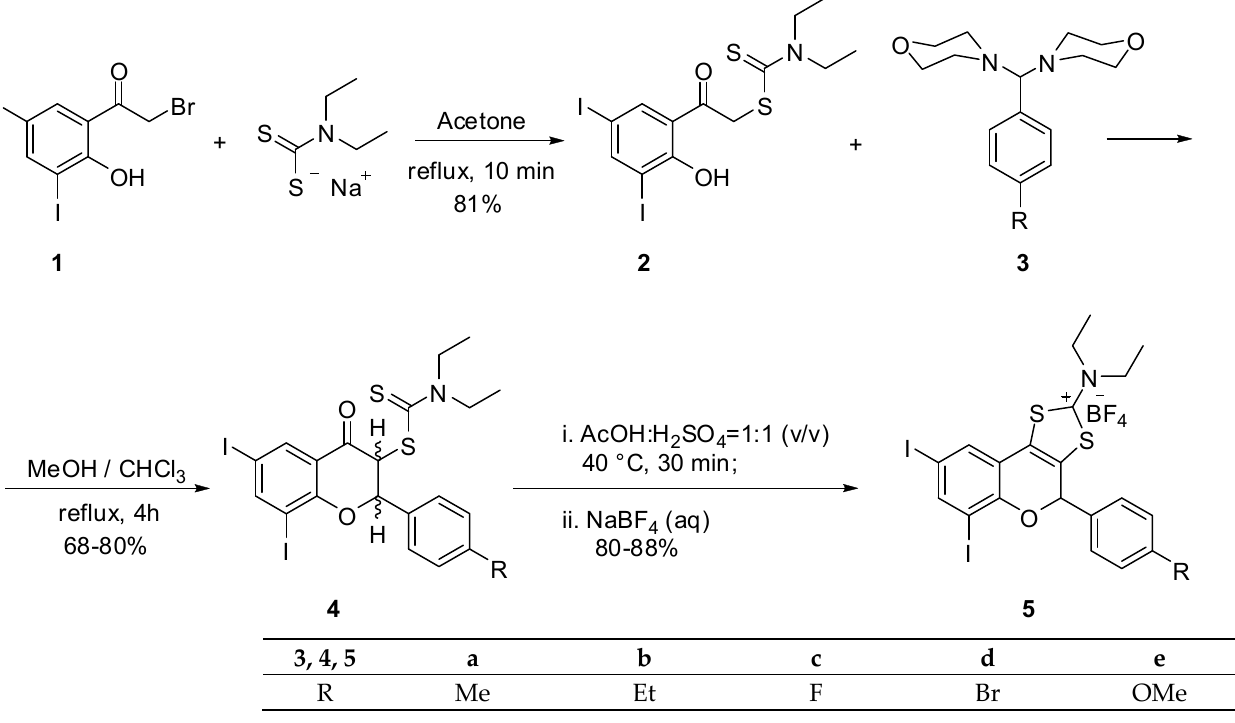
Scheme 1. The synthesis of tricyclic flavonoids 5a – e from flavanones 4a – e . The later have